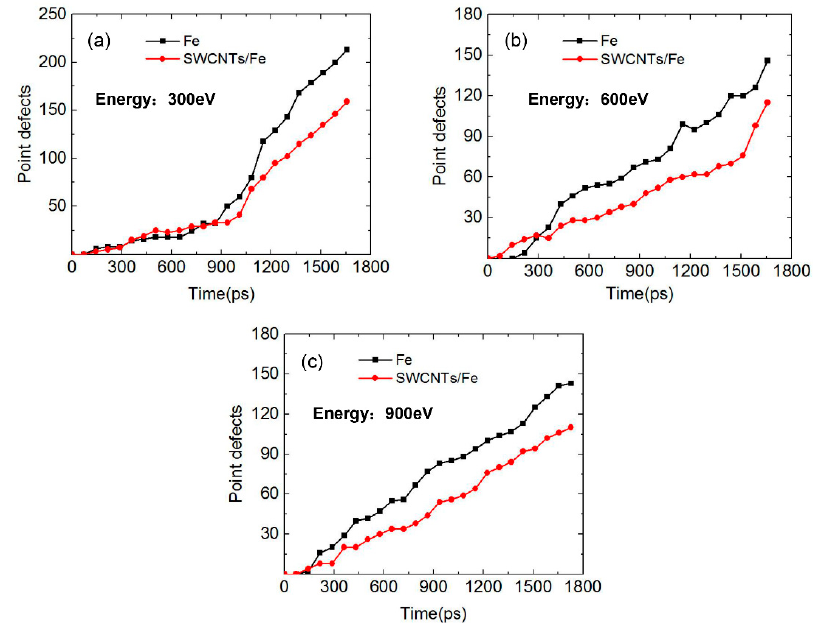
Figure 6. The number of point defects in Fe and SWCNT/Fe during the irradiation process. The incident energies of the He atoms were ( a ) 300 eV; ( b ) 600 eV; and ( c ) 900 eV. Materials 2018 , 11 , x FOR PEER REVIEW The spatial distribution of point defects in bcc-Fe and the SWCNT/Fe composite at t = 1200 ps are shown in Figure 7a–c for incident energies of 300 eV, 600 eV, and 900 eV, respectively. When the incident energy was 600 eV, He bubbles formed at the upper part of the Fe matrix, which resulted in a cluster of vacancies in the matrix (as shown by the green balls in Figure 7a). At the same time, Fe atoms moved toward the surface and were out of initial sites, which led to plenty of interstitials in positions near the surface. If the incident energy was higher, as shown in Figure 7b,c, point defects tended to occur in deeper sites. The defects near the upper SWCNTs were notable. It could be inferred that SWCNTs played an important role in trapping point defects.